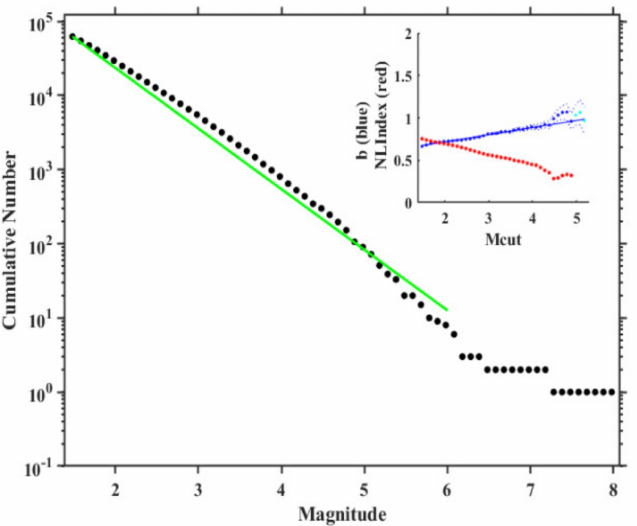
Figure 4. Frequency-magnitude distribution and